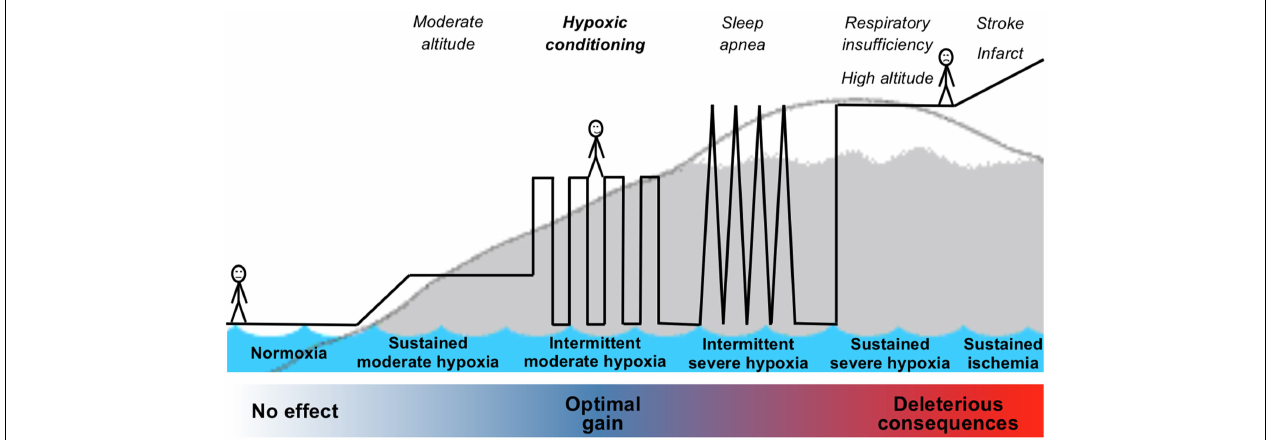
FIGURE 2 | Schematic representation of the continuum from normoxia to severe hypoxia including hypoxic exposure leading to hypoxic conditioning